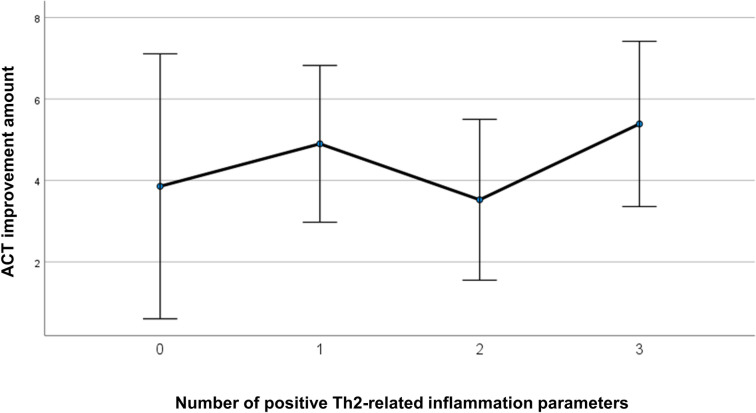
Correlation between ACT improvement and the number of increased type 2-related inflammation parameters.An increased level of each type 2-related marker was counted as 1, resulting in a sum ranging from 0 (none of parameters were elevated) to 3 (all 3 type 2 markers were elevated) for each patient. Error bars: +/- 2SE.